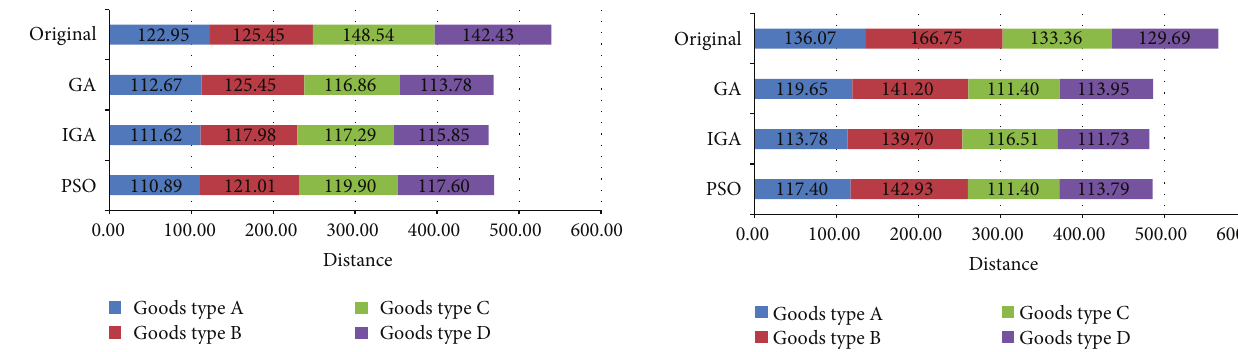
Figure 16: The Gantt chart for different travelled distances under Case